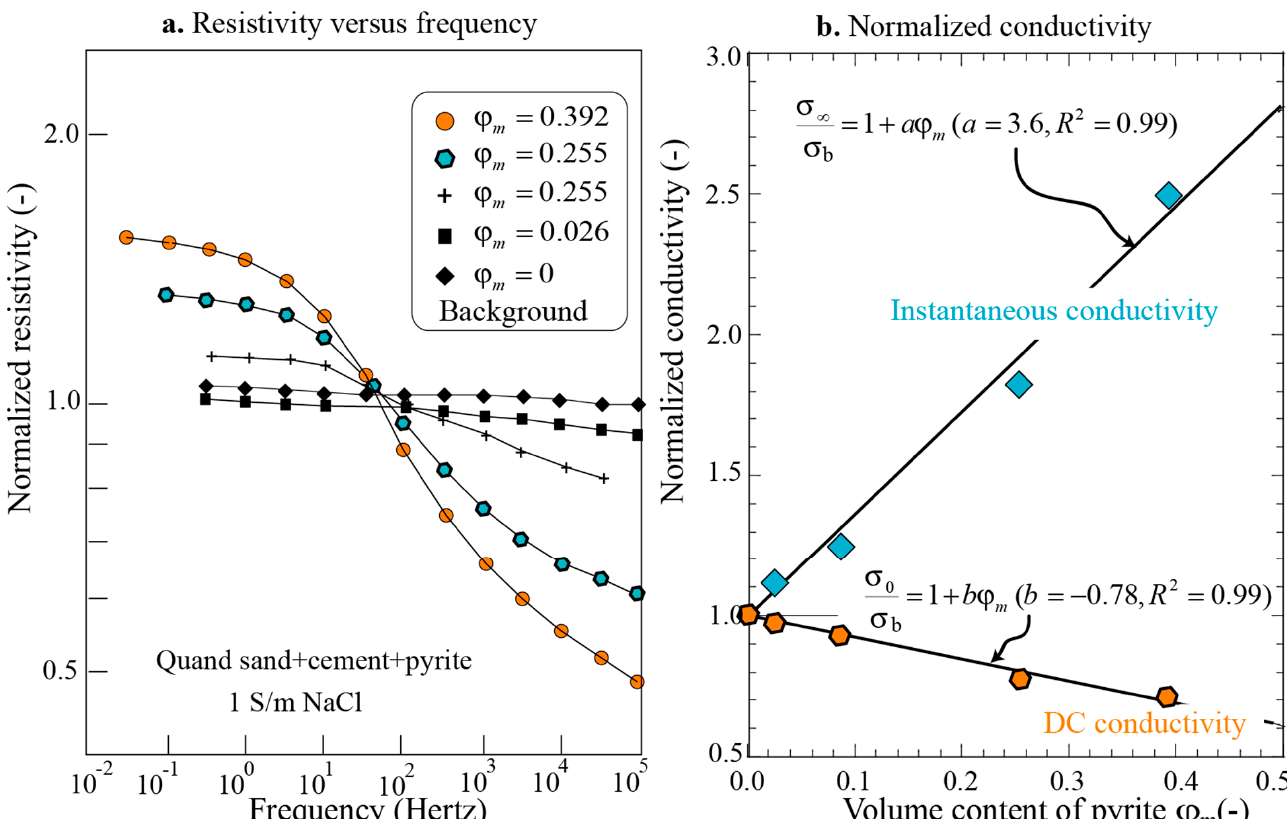
Figure 17. Influence of the volumetric content of pyrite on the amplitude of the resistivity. ( a ) In- fluence of the volumetric pyrite content on the resistivity spectra. The resistivity is normalized by the resistivity of the background porous material. The plain lines are just guides for the eyes. ( b ) Influence of the volumetric pyrite content on the low ‐ frequency and high ‐ frequency electrical conductivity. The data are normalized to the conductivity of the background ( σ ), for which ϕ m = 0. Data are from De Witt (1979, p. 55) [71]. The theory predicts the following trends: σ ∞ = σ b ( 1 + 3 ϕ m ) and σ 0 = σ b ( 1 − 3 ϕ m /2 ) for spherical grains. Modified from [47].